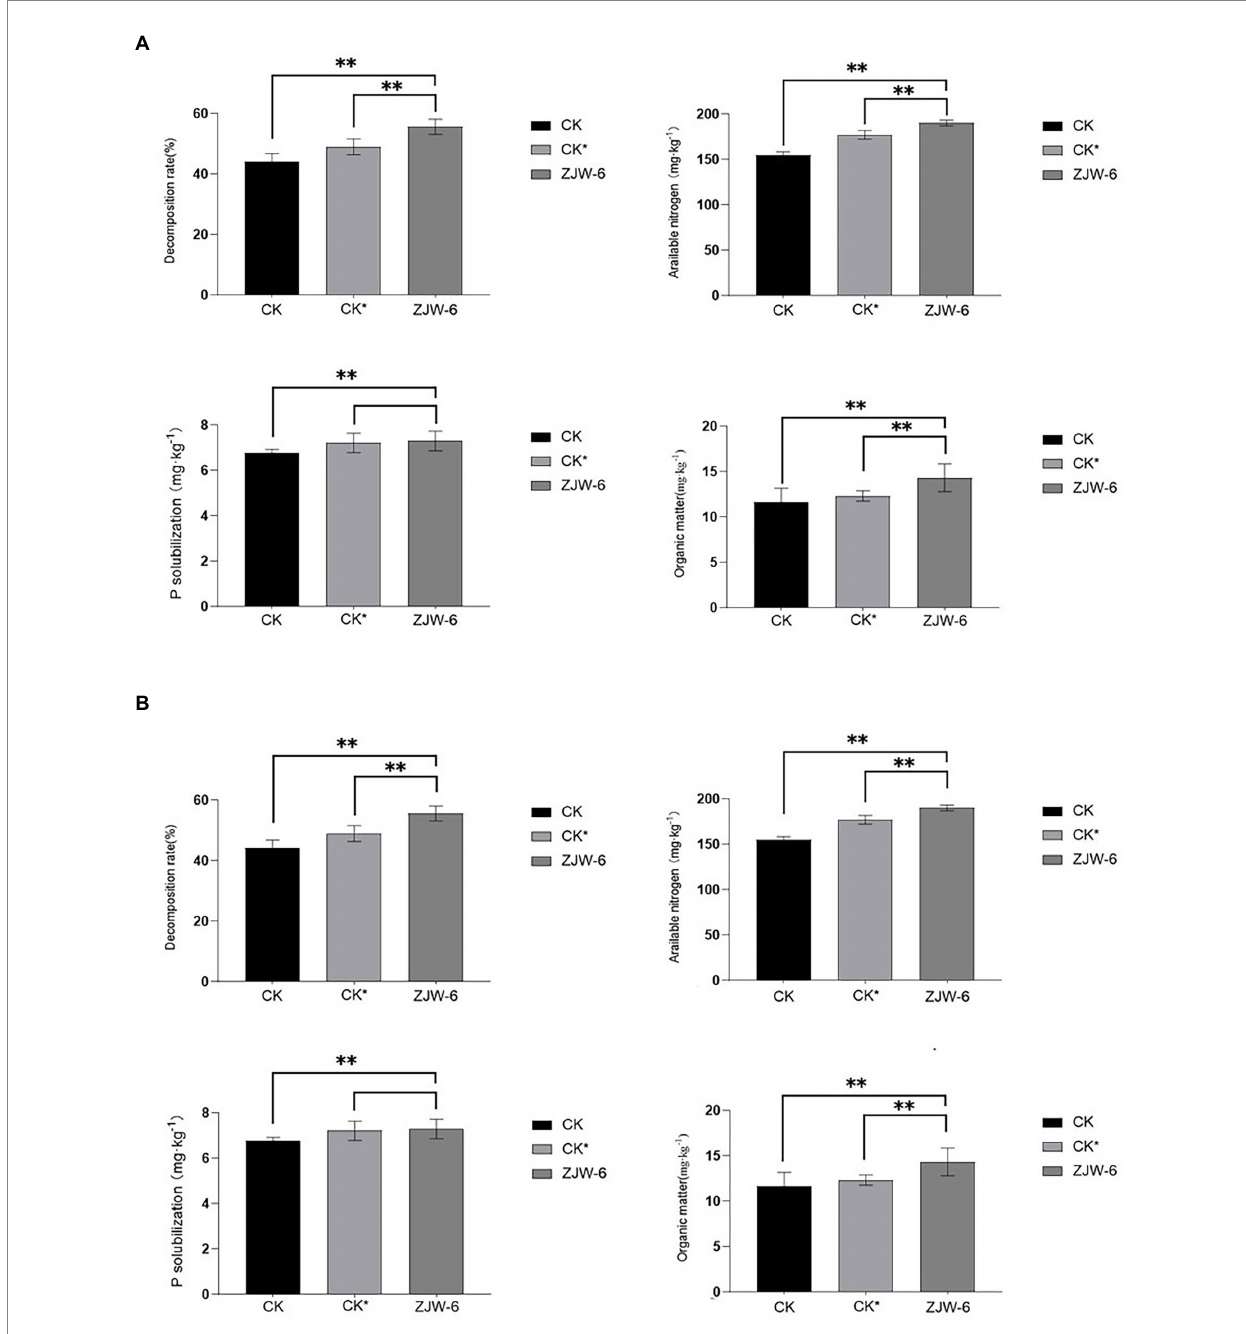
FIGURE 10 Index of soil quality. (A) seedling stage; (B) tillering stage. ** p <